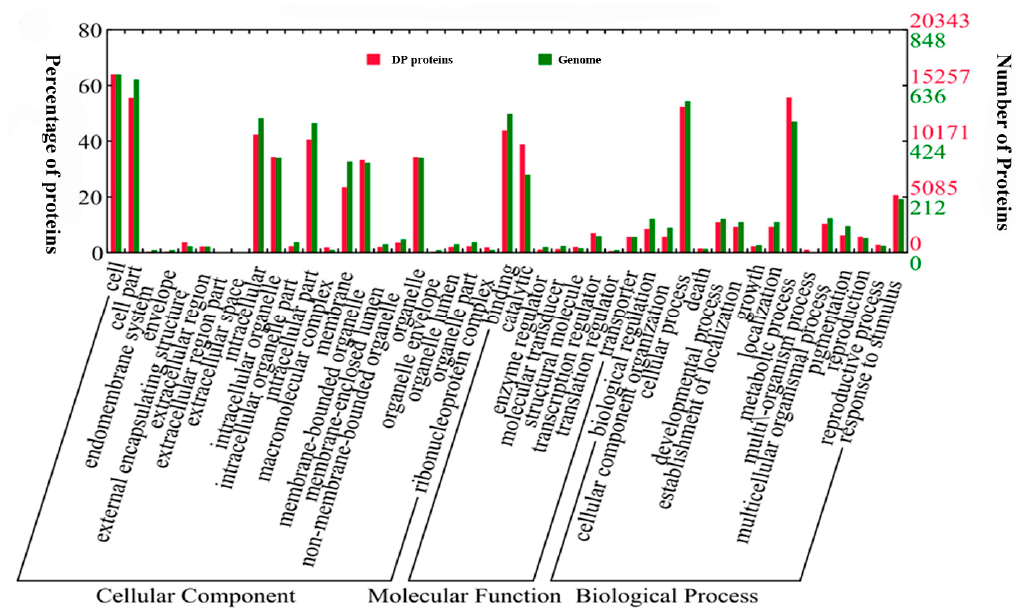
Figure 4. GO (Gene Ontology) analysis of DP proteins in terms of cellular components, molecular functions and biological processes.